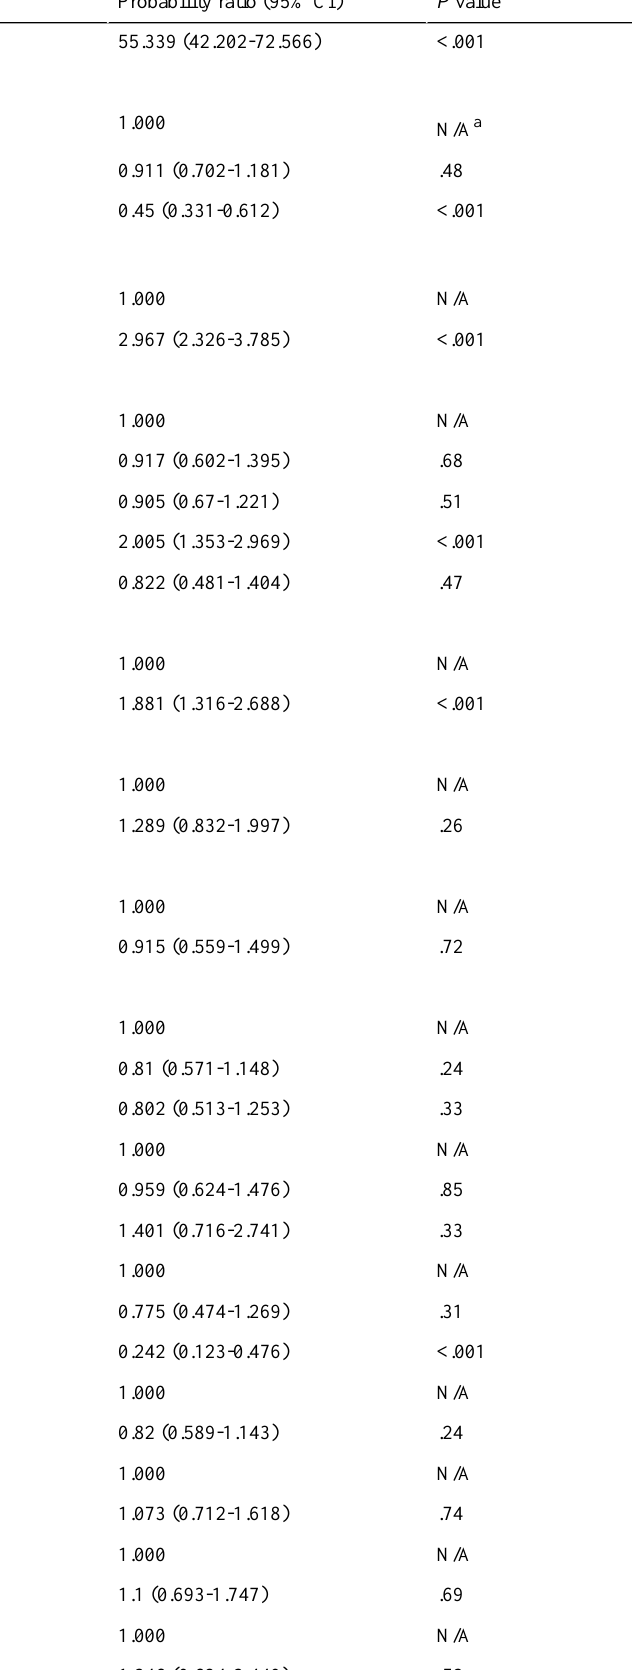
Table 2. Negative binomial regression examining the associations between demographic characteristics, substance use, and the interaction between demographic characteristics and substance use with the number of Instagram